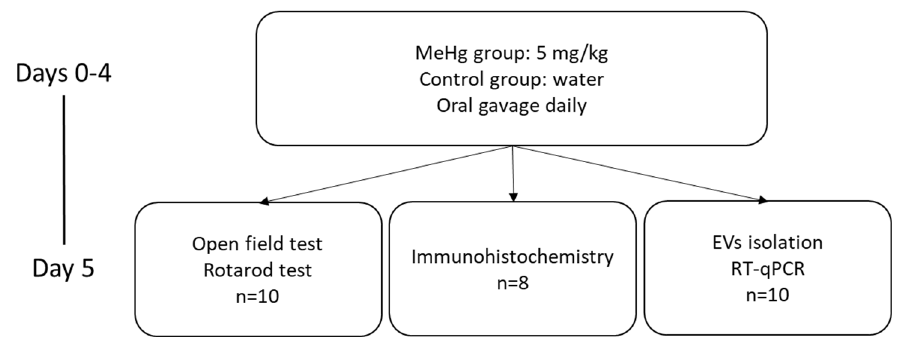
Figure 6. Experimental design.